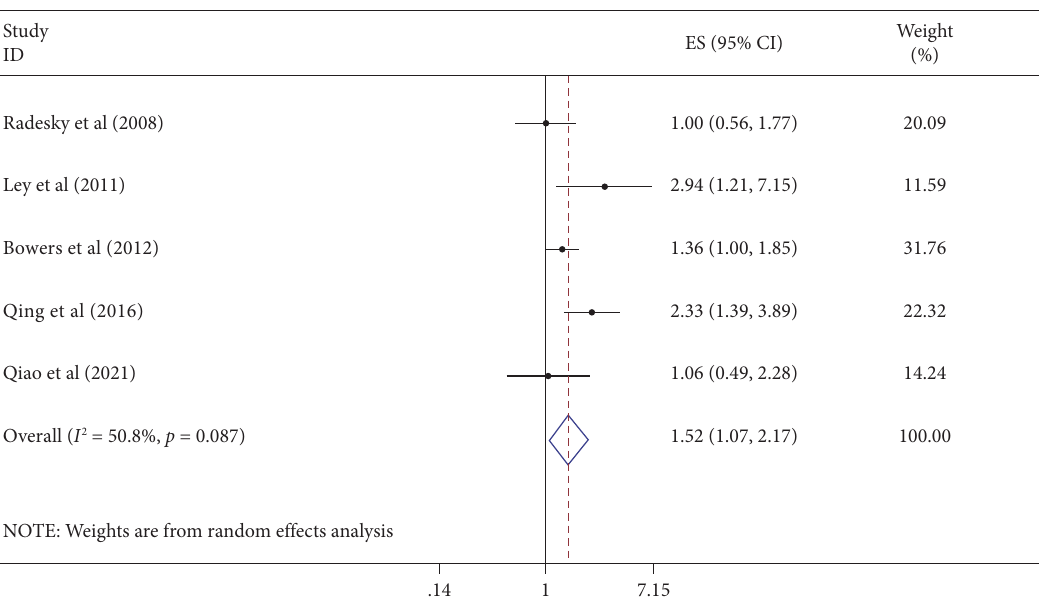
Figure 3: Forest plot derived from random-efects meta-analysis of cohort studies investigating the association between high versus low intake of animal protein consumption and gestational diabetes mellitus. CI, confdence interval; ES, efect size.